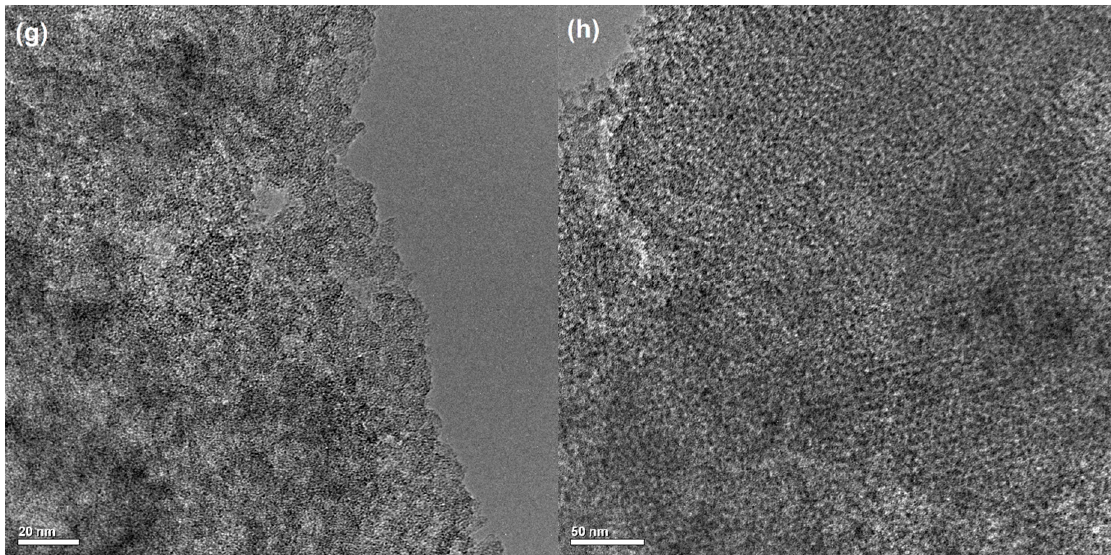
Figure 4. TEM images for the RIAA ( a , b ), W1 ( c , d ) W2 ( e , f ) and W3 ( g , h ) carbons. The dependences of surface charge density vs. pH (Figure 5) show that most of the carbons are basic in nature, with a point of zero charge (pH PZC ) in the range of 8.3–9.2. While the W3 carbon is acidic, pH PZC is 3.8. This may be explained by some silica residues in the small pores of W3 carbon. In the literature it can be found that pH PZC for silica is in the range of 2.5–3.5 [57]. Generally, under the experimental conditions (neutral pH) all carbons, except W3, exhibit a positive charge.